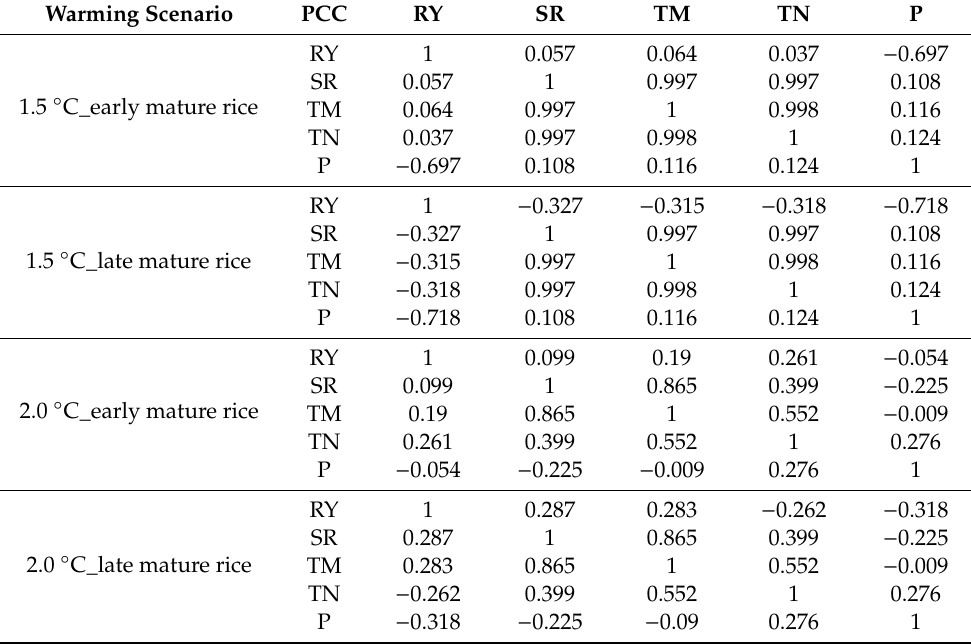
Table 4. Pearson Correlation Coe ffi cient (PCC) of climatic variables and rice yields. Rice Yield